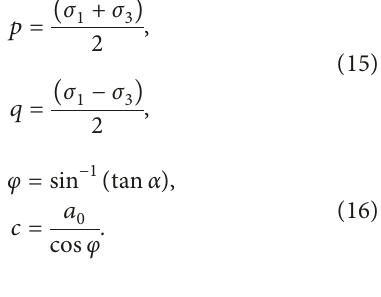
Figure 6: Stress Mohr circle after rotating 2 α